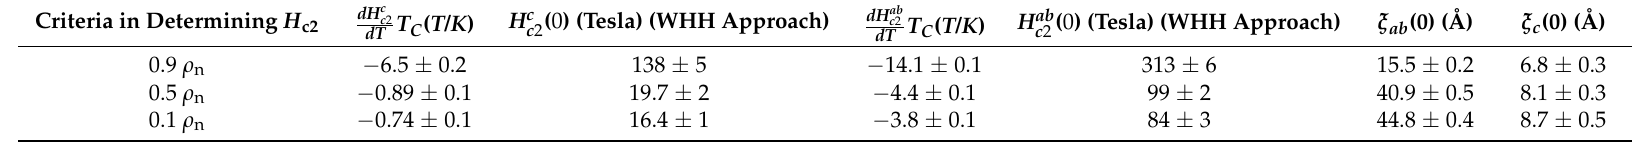
Table 1. The upper critical field and coherence length of Ca 10 (Pt 4 As 8 )((Fe 0.86 Pt 0.14 ) 2 As 2 ) 5